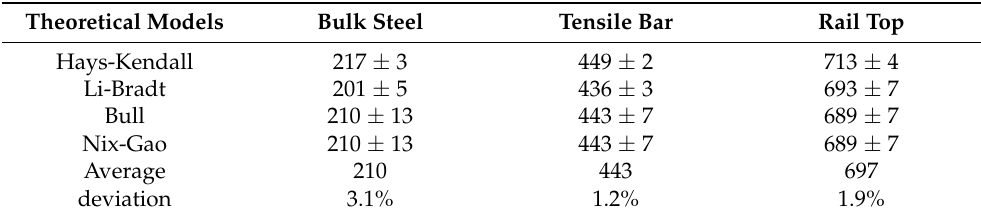
Table 3. Determination of the real hardness ( H 0 , in kgf/mm 2 ) of the strained Hadfield steel using the theoretical